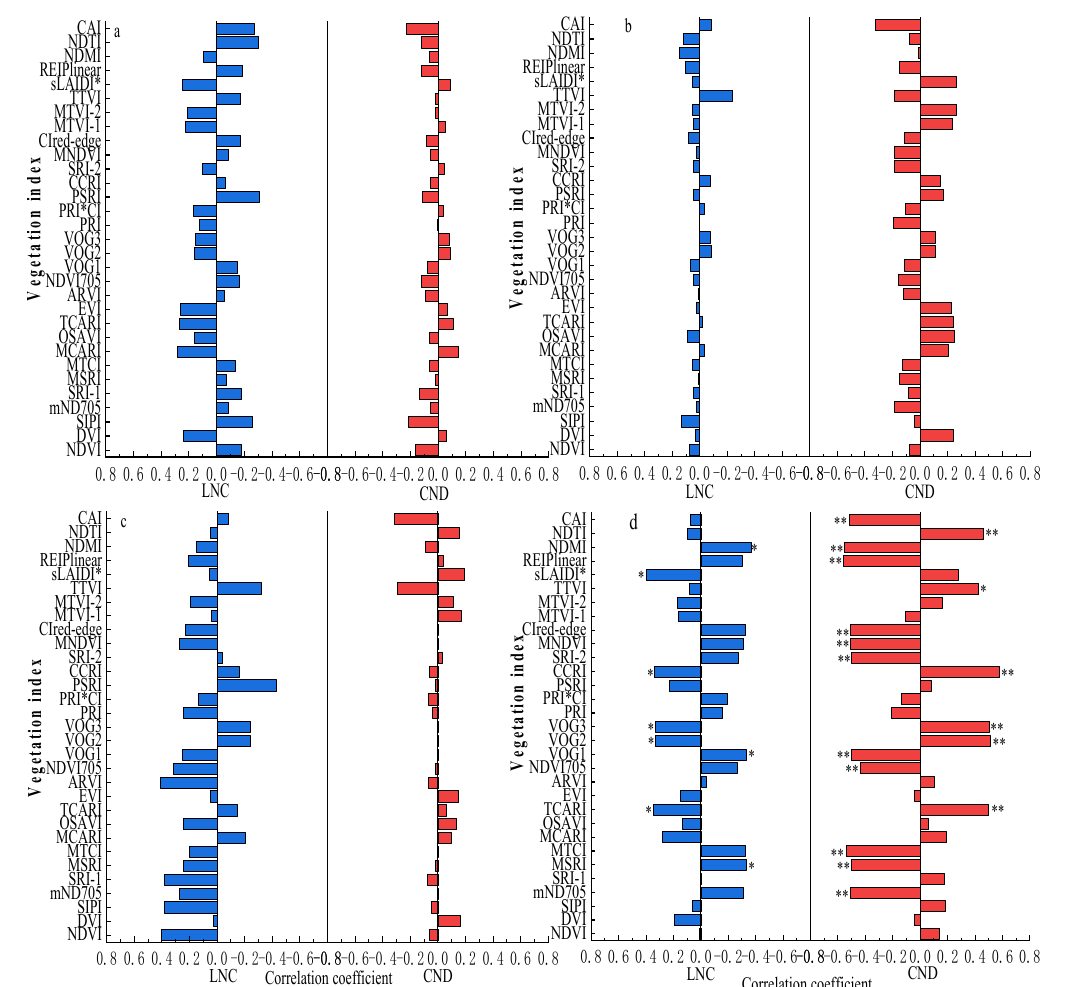
Figure 6. Correlation between LNC, CND, and vegetation index in 2019 (Xinluzao 53, ( a ): bud stage; ( b ): initial flowering stage; ( c ): flowering and boll stage; ( d ): full ‐ boll period. * indicates that significant difference is achieved under p < 0.05; ** indicates that significant difference is achieved under p < 0.01 ).